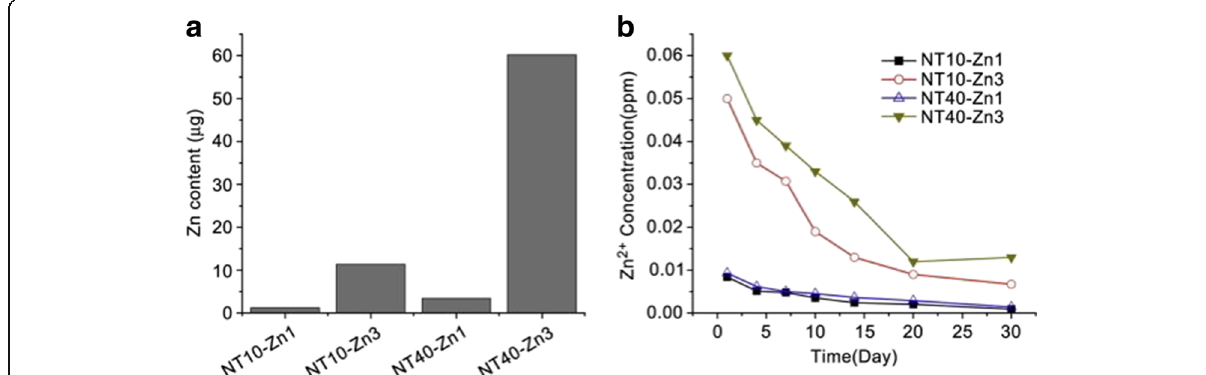
Fig. 11 a Total amounts of Zn incorporated into the NT-Zn samples for the 1 cm 2 coatings and b non-cumulative Zn release profiles from NT-Zn into PBS. Reproduced from ref. [181]